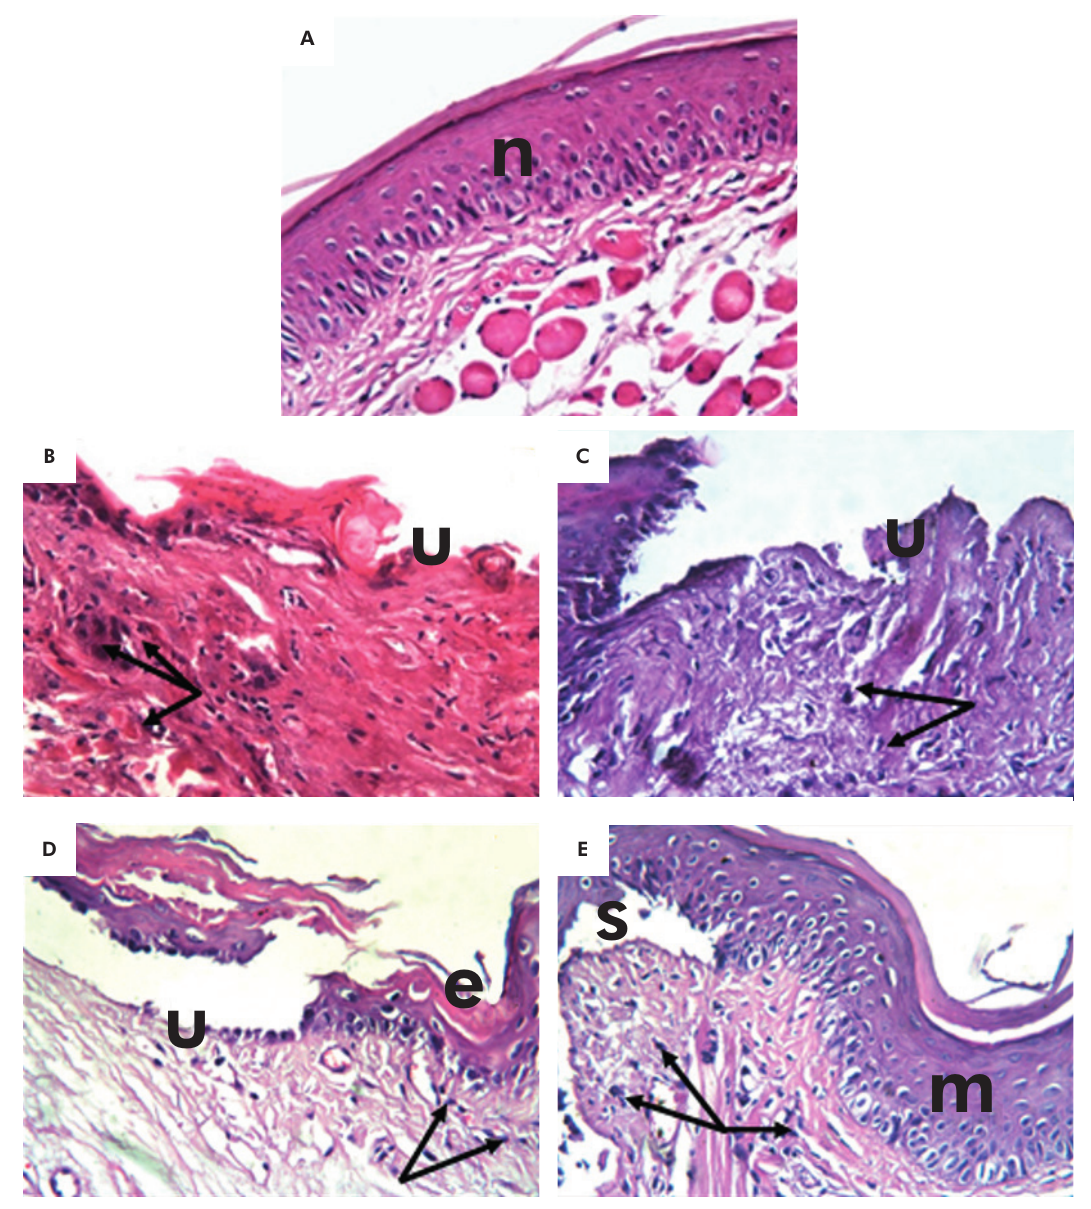
Figure 2. Photomicrograph of the lower lip at the 3rd day post-ulceration of (A) group C, (B) group R, (C) group AV, (D) group NS, and (E) group AV+NS, showing normal epithelium with thin keratin layer (n), ulcerated oral epithelium (u), chronic inflammatory cells (black arrow), retained epithelium (e), almost intact epithelium with cellular vacuolization (m) and area of epithelial separation (s). H&E